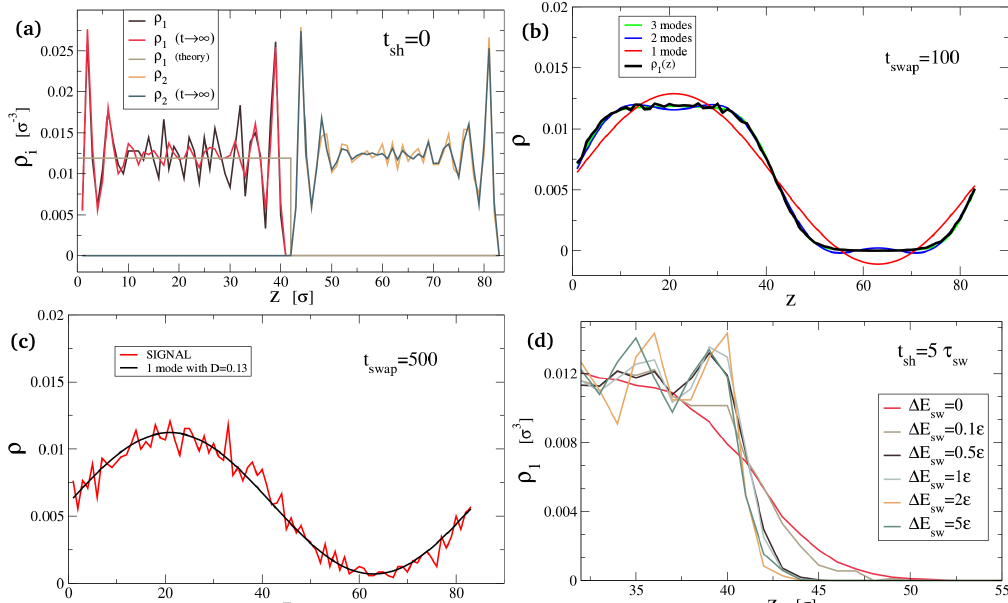
Figure 5. Density profiles at t sh = [ 0;5;20 ] τ sw . ( a ) At t sh = 0, layering is visible in the density profiles, so the square wave cannot capture the full details yet. The layers are stable if we equilibrate without healing (preventing swap). ( b ) At t sh = 5 τ sw , the density profile is well-reproduced by the three slowest modes of the Fourier expansion. The system is diffusing with D ≈ 3.12 σ 2 / τ sw when ∆ E sw = 0. ( c ) At t sh = 20 τ sw , only one mode is still present. Notice that the diffusion is far from reaching equilibrium. ( d ) The diffusion is slower when swaps are hindered by an energy barrier ∆ E sw > 0.